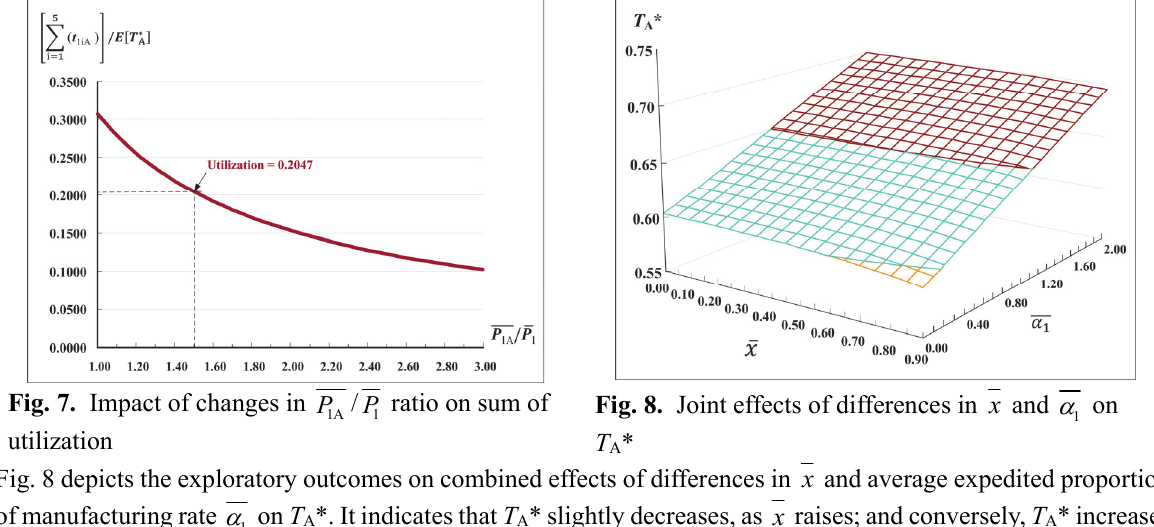
P / P ratio on sum of 1A 1